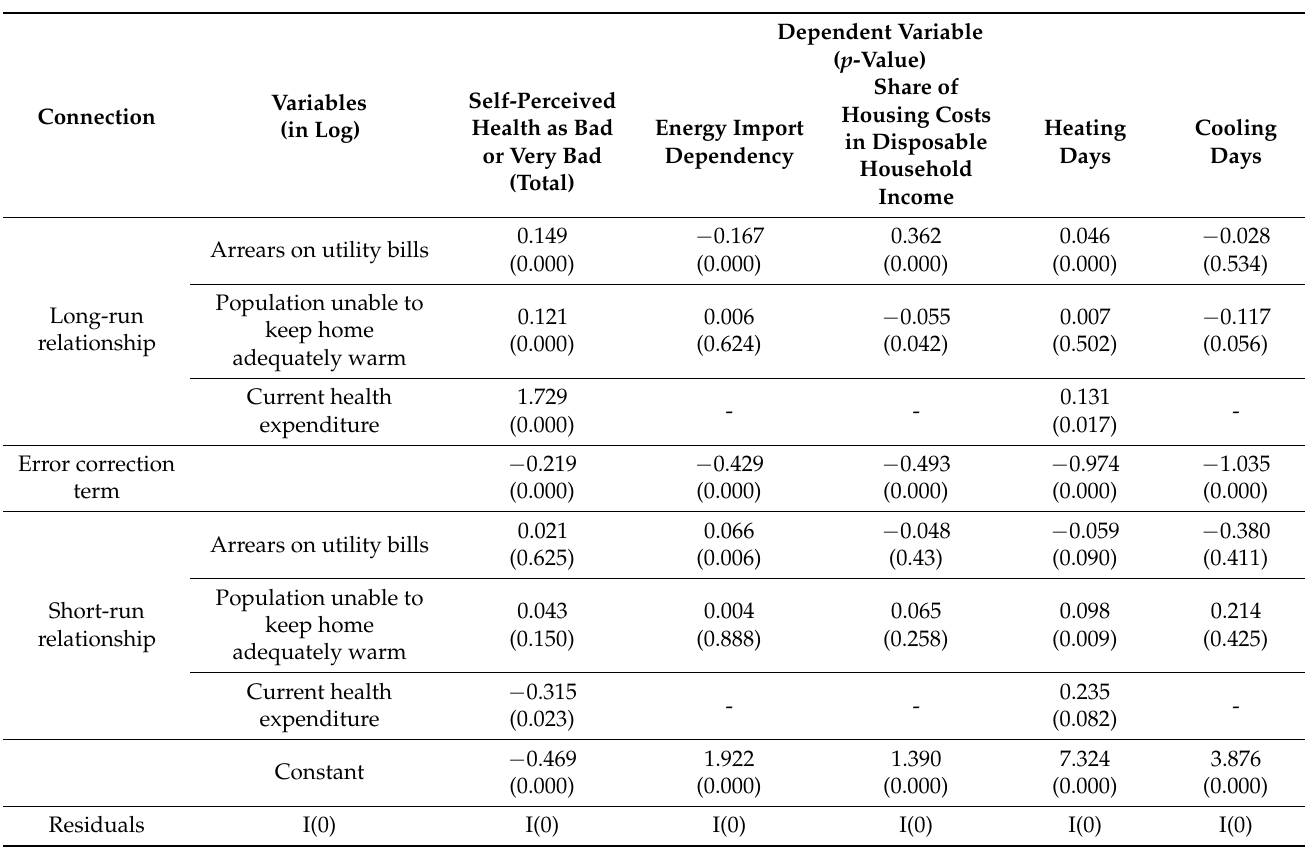
Table 5. PMG estimators for the EU-27 countries